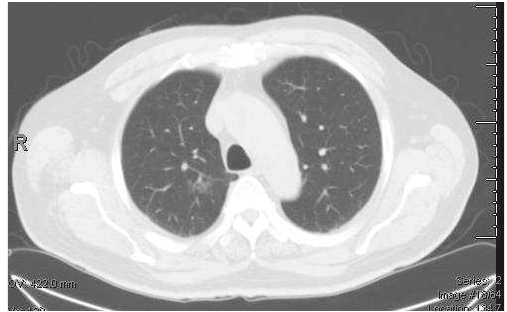
Figure 5: CT scan showing a 1.9 × 1.1 cm rightupper lobelung